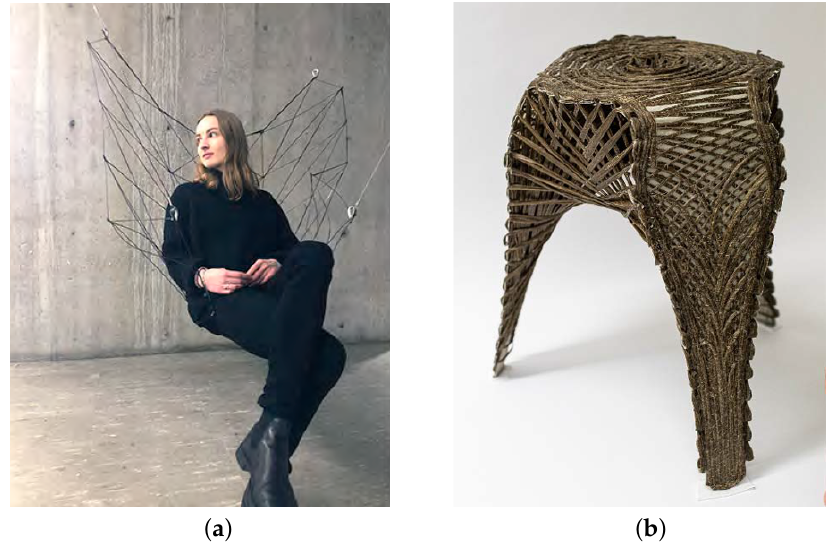
Figure 1. State of the Art ( a ) “AEROCHAIR” [15] ( b ) “FlexFlax”